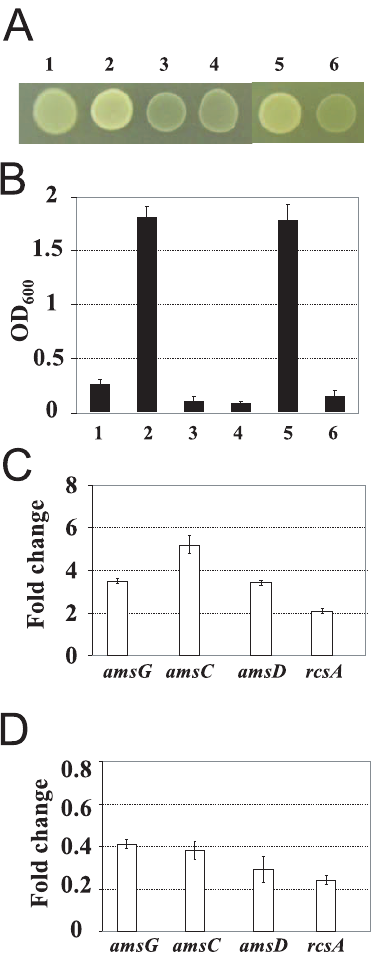
Figure 1. AmyR regulates amylovoran production and gene expression. A. Growth of Erwinia amylovora wild type (WT), amyR mutant, complementation strain and WT containing pAmyR2 plasmid on Luria-Bertani plates. Pictures were taken at 24 h post-inoculation. pAmyR2: plasmid containing 1.1-kb PCR fragment of Erwinia amyR gene and promoter in pGEM T-easy vector. B . Amylovoran production of E. amylovora wild type (WT), amyR mutant, complementation strain and WT containing pAmyR2 plasmid in vitro . Bacterial strains were grown in MBMA media with 1% sorbitol for 24 h at 28 u C with shaking. The amount of amylovoran was measured with the CPC assay and normalized to a cell density of 1. Data points represent means of three replicates 6 standard deviations. Similar results were obtained in three independent experiments. 1: Ea1189, 2: D amyR , 3: D amyR (pAmyR2), 4: D amyR (pAmyR3), 5: Ea273, 6: Ea273 (pAmyR2). C . Relative quantifica- tion of amylovoran biosynthetic genes in amyR mutant compared to WT strain by qRT-PCR. Bacterial cells were grown in MBMA with 1% sorbitol for 18 hours at 28 u C with shaking. D . Relative quantification of amylovoran biosynthetic genes in WT containing pAmyR2 plasmid compared to WT strain by qRT-PCR. Bacterial cells were grown in MBMA with 1% sorbitol for 18 hours at 28 u C with